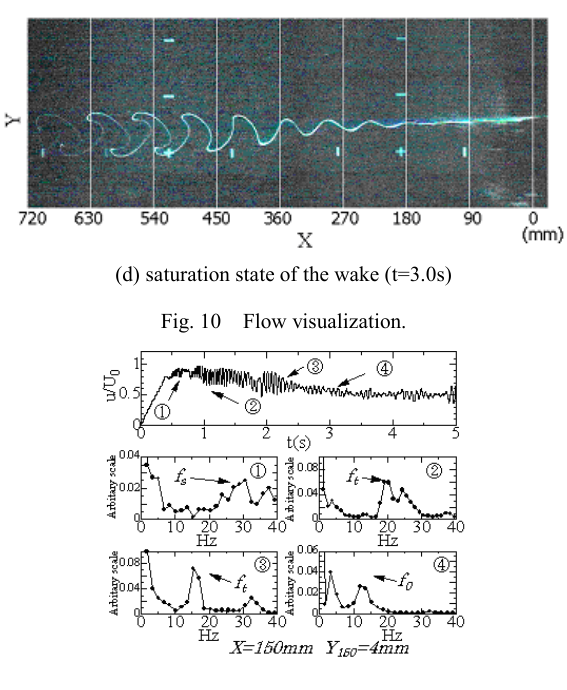
Fig. 11 Power spectra at X=150mm, Y150=4mm (natural).